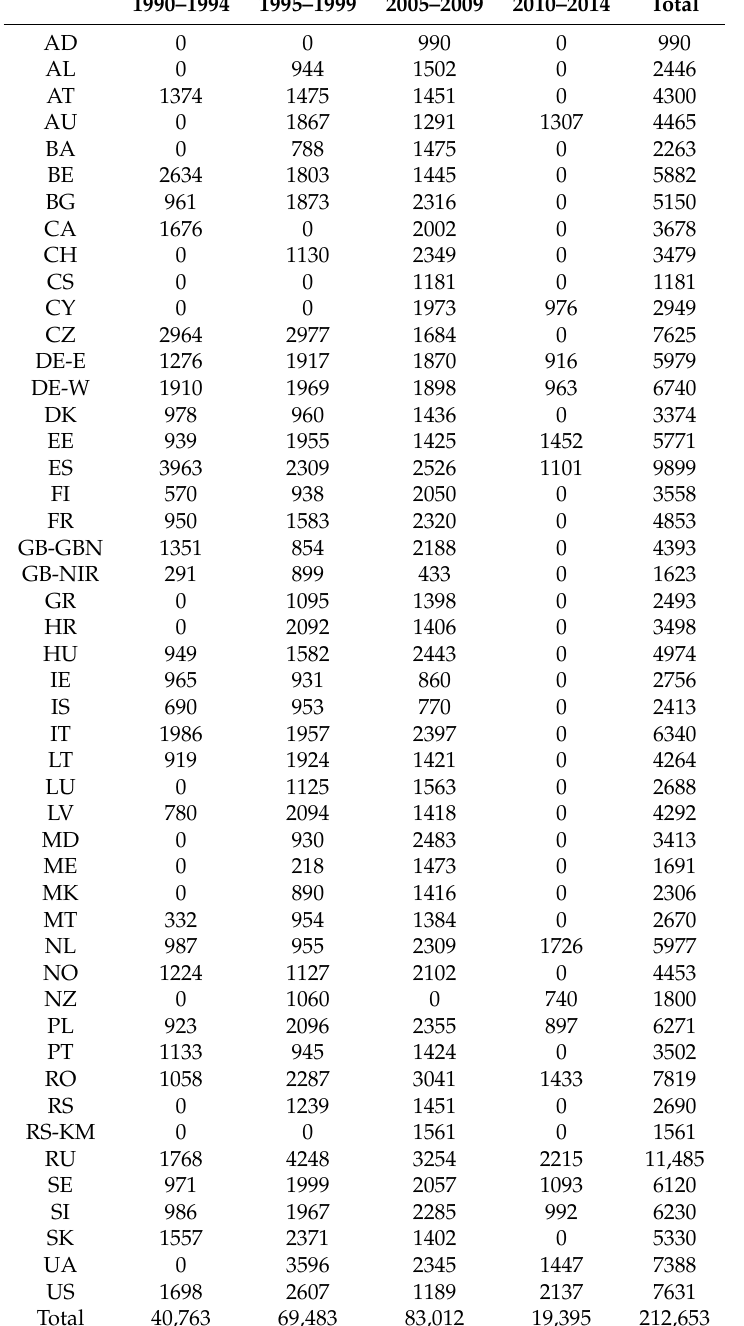
Table A1. The number of observations by country and period (relative importance of